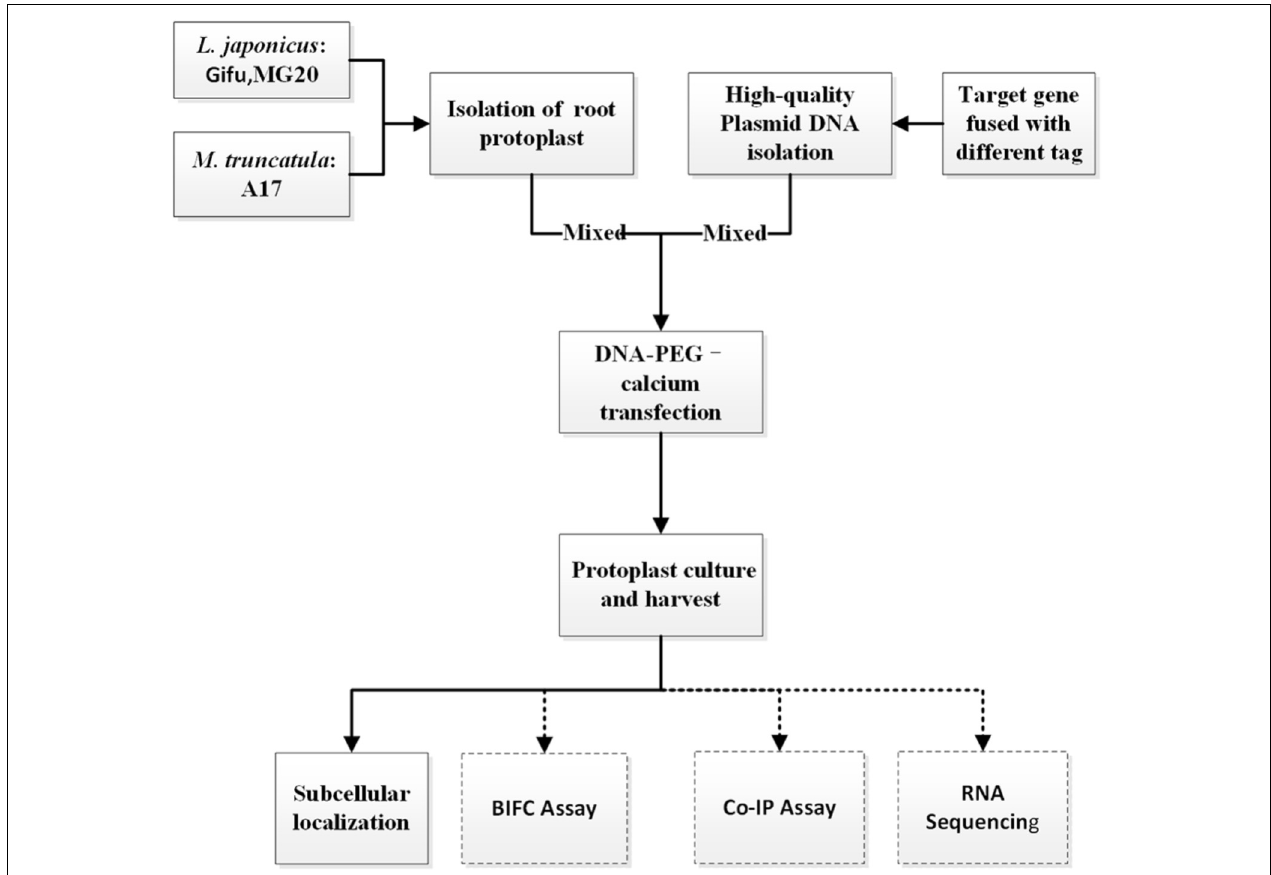
FIGURE 1 | An overview flowchart describing transient gene expression systems using legume root protoplasts.